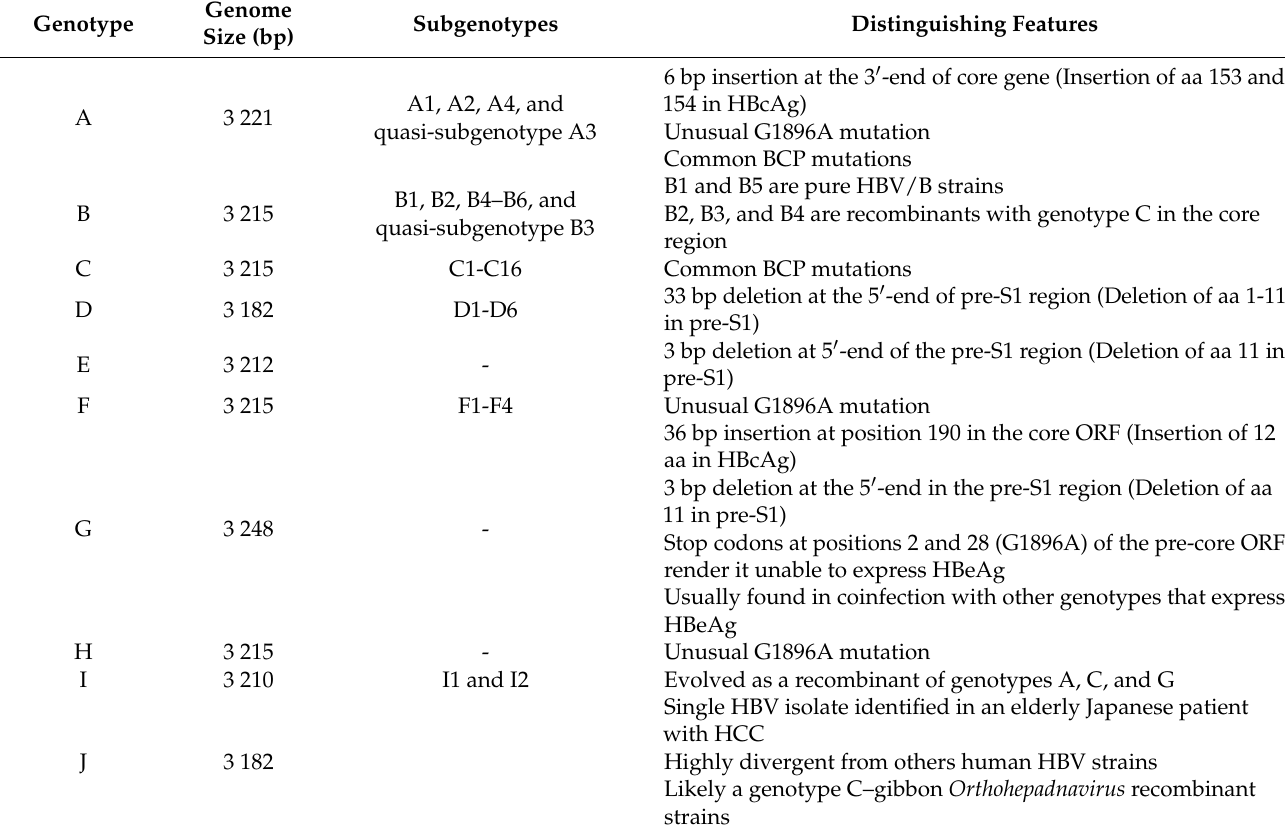
Table 1. HBV genotypes and their distinguishing